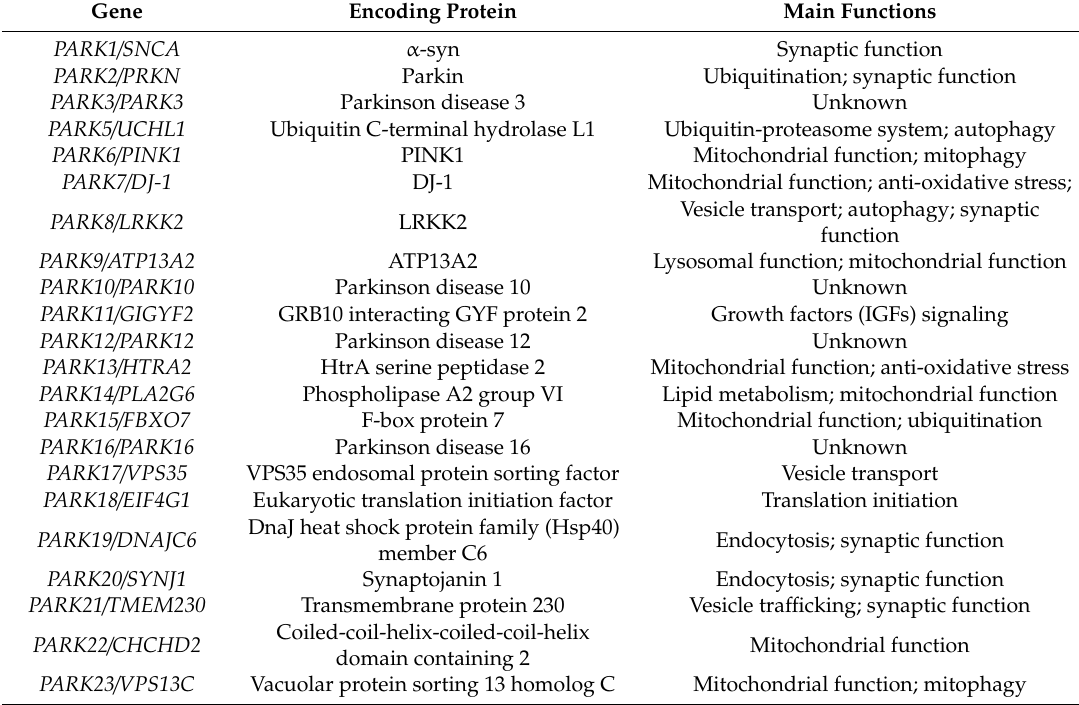
Table 1. PD-Causing Genes and their Main